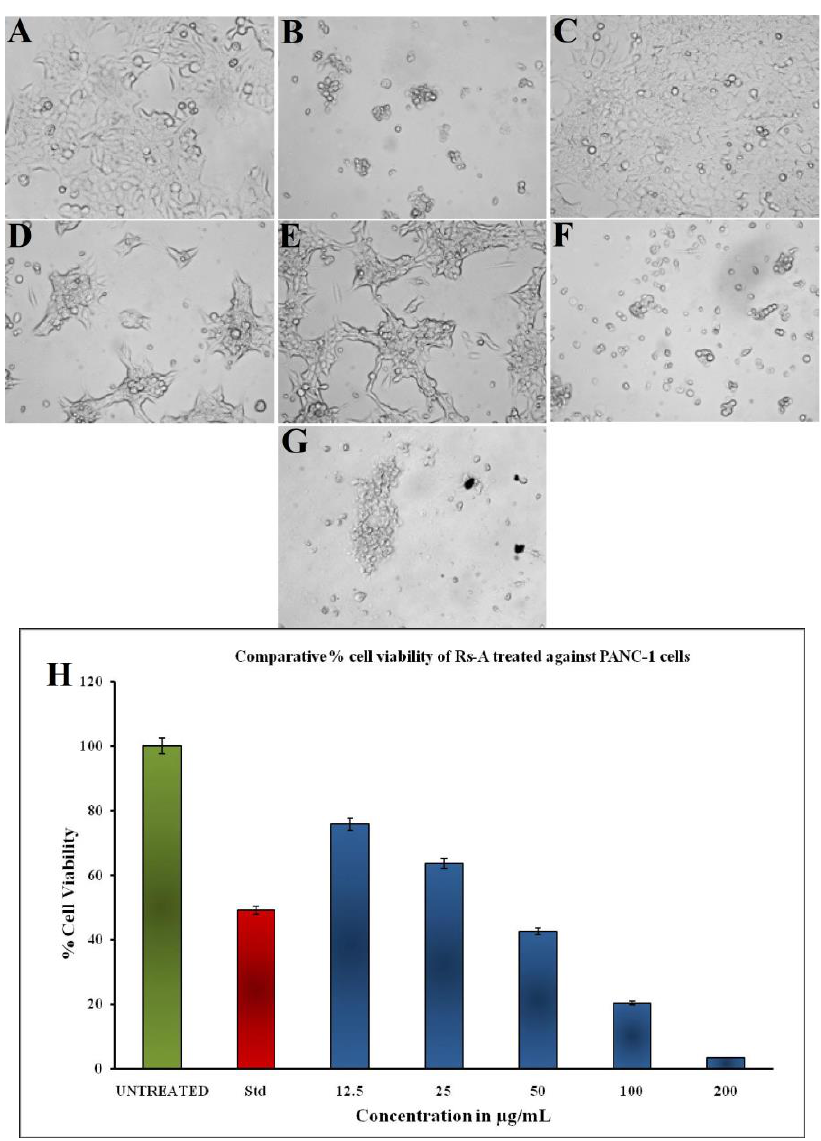
Figure 10. Cell viability of PANC-1 cells treated with synthesized RsFb-AgNPs: ( A ) Negative control, ( B ) Positive control, ( C ) 12.5 µ g/mL, ( D ) 25 µ g/mL, ( E ) 50 µ g/mL, ( F ) 100 µ g/mL, and ( G ) 200 µ g/mL. ( H ) Bar graph showing the comparative percentage of cell